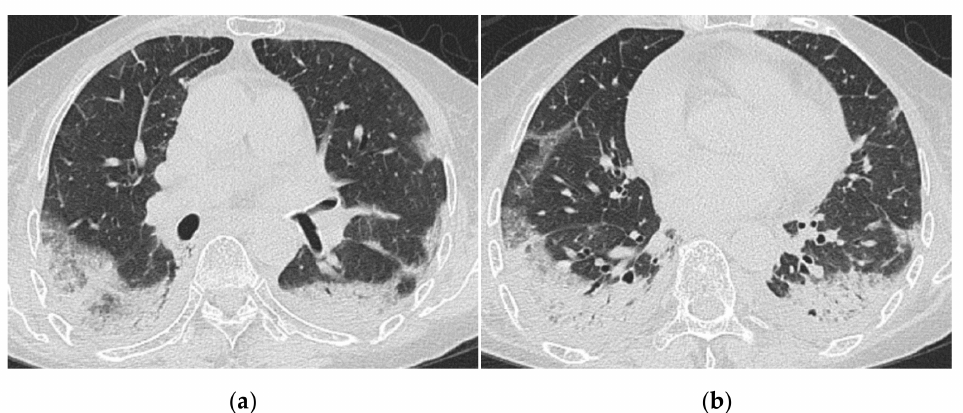
Figure 7. A 70-year-old woman with rapidly progressive interstitial lung disease associated with clinically amyopathic dermatomyositis (antibody unknown). HRCT images ( a , b ) show diffuse ground-glass opacification and consolidation just below the pleura. Crazy-paving appearance, interlobular septal thickening and bilateral pleural effusions are also seen. The patient died 2 weeks after